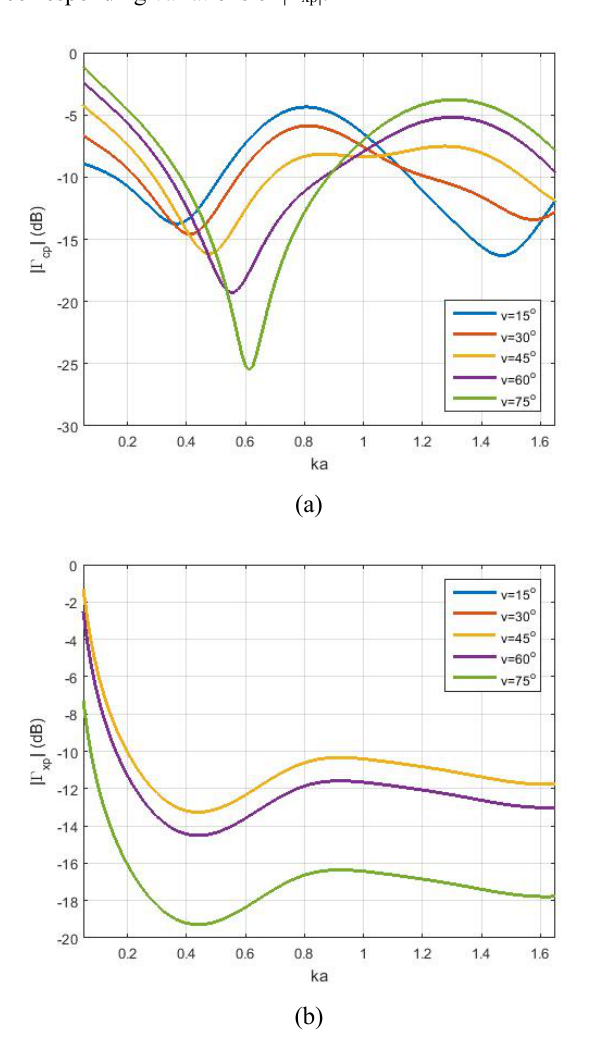
Figure 4: Variations of the reflection coefficient magnitudes with ka for buried PEMC circular cylinders of radius a , with d =2.5 cm, ρ 0 =3.0 cm, and η 0 / η 1 = 0.5, for five different values of ν ; (a) co-polar coefficient; (b) cross polar